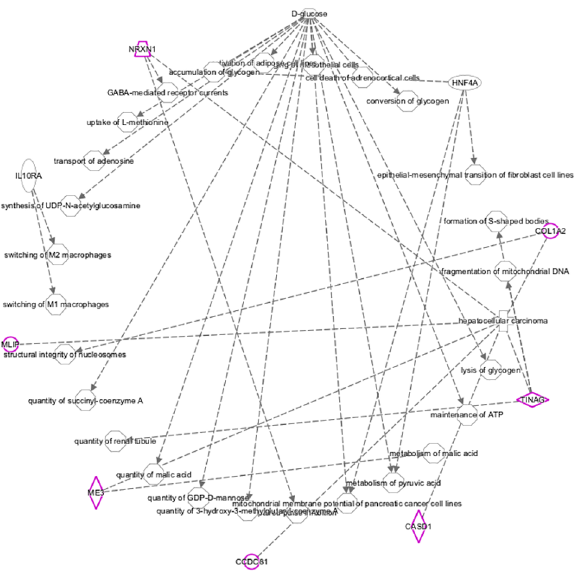
Fig 7. IPA molecule function network. The focus moleculesare highlightedin purple. This network shows the central role of D-Glucosemoleculeand its connections with the function of the moleculesclose to significantSNPs in the present